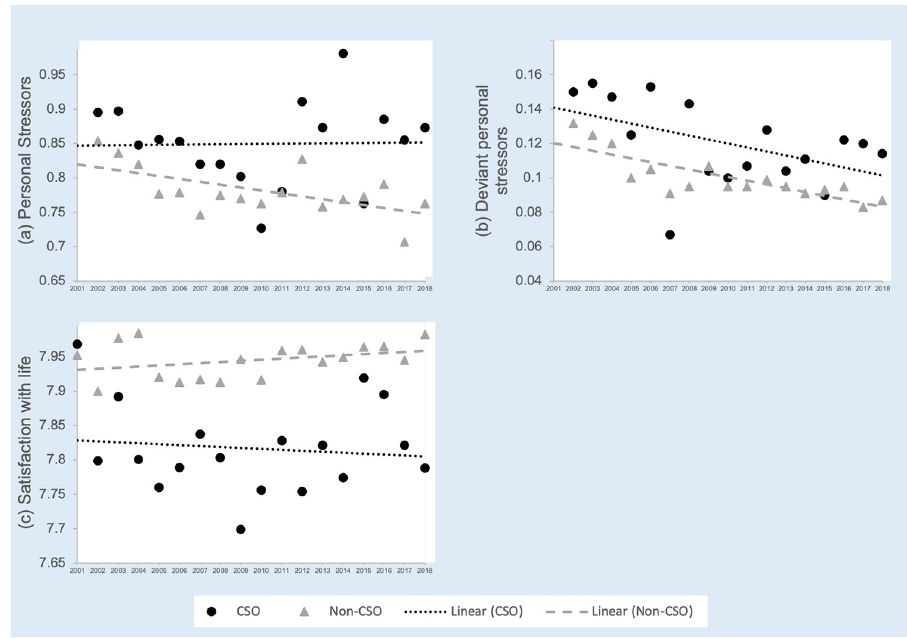
Fig 2. a-c. The trajectories of overall wellbeing for CSO and